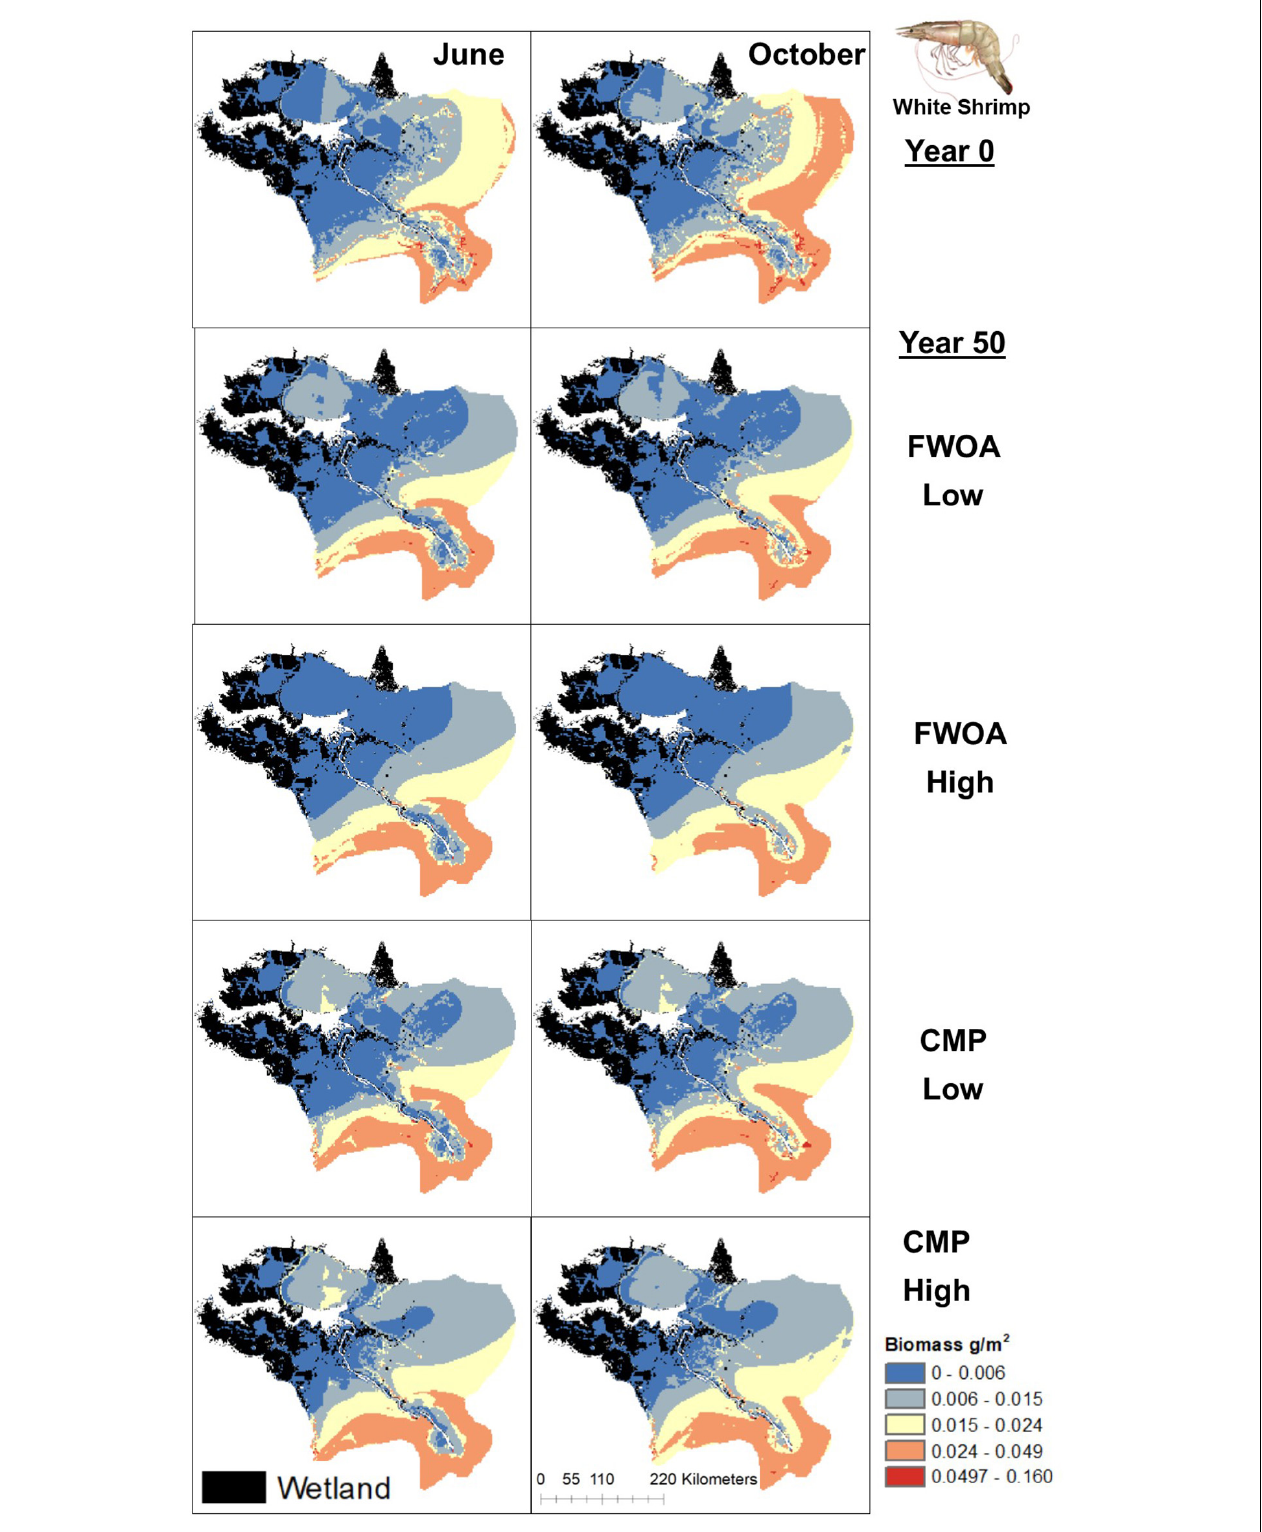
FIGURE 13 | Spatial distribution of juvenile White Shrimp in different simulations. Output is shown from June and October in Year 0 and Year 50, under “Low” and “High” relative sea level rise (see Supplementary Table S6 for scenarios), and with Coastal Master Plan (CMP) implementation and without (FWOA).